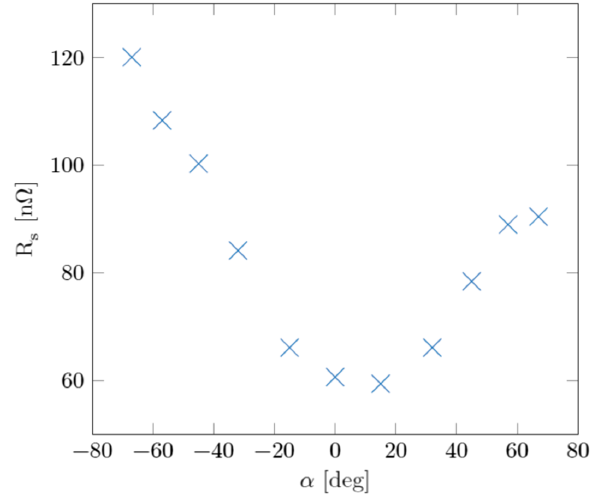
FIG. 16. Calculated surface resistance vs polar angle, with applied field in α ¼ 90 °. The surface resistance is mapped similarly to Fig. 13. Blue marks show average surface resistance of each row in the corresponding map. The map is not